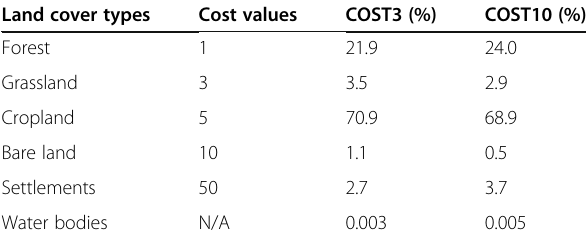
Table 1 Land cover types and their cost values Land cover